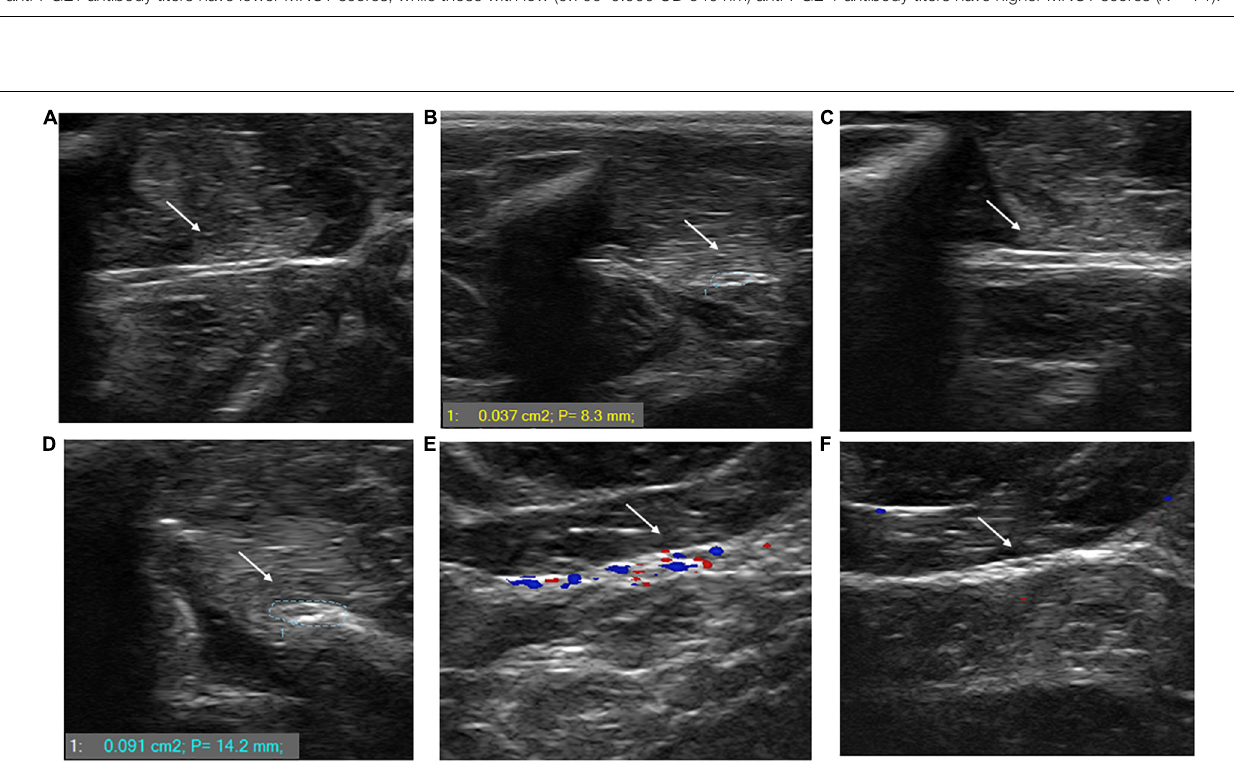
FIGURE 5 | M. leprae infection causes nerve enlargement in armadillo peripheral nerves. Ultrasonography of the posterior tibial nerve was performed using a SmartUS transducer probe with a linear broadband frequency of 1.5–15 MHz connected to a Sierra Summit basic system. The posterior tibial nerve is shown along its longitudinal (A) and transverse (B) axes in an uninfected armadillo and a M. leprae- infected armadillo [ (C,D) , respectively]. The nerve diameter of the M. leprae- infected armadillo is 0.096 cm 2 indicating nerve enlargement compared to the nerve diameter of the uninfected armadillo (0.037 cm 2 ). Ultrasound with color Doppler imaging in M. leprae- infected armadillos showed increased blood flow in animals at late stage leprosy disease (23 months post-infection) that were positive for anti-PGL-1 antibodies (E) compared to armadillos that were negative for anti-PGL-1 antibodies at 9 months post-infection (F) . The intense colors indicate lower velocity of the blood flow traveling away and toward the transducer ( N =